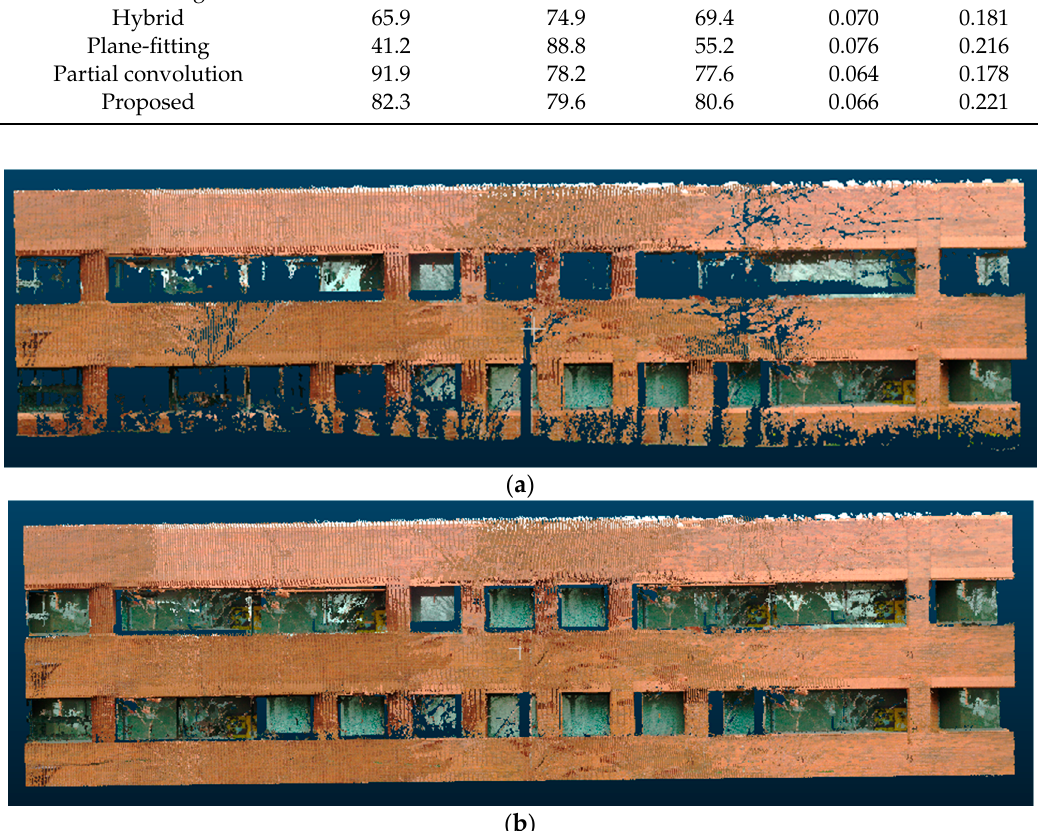
Figure 18. Visual comparison between ( a ) natural ground truth and ( b ) manual ground truth for the Pettit building scene. Table 6. Performance comparison between using natural ground truth and manual ground truth for the Pettit building scene.